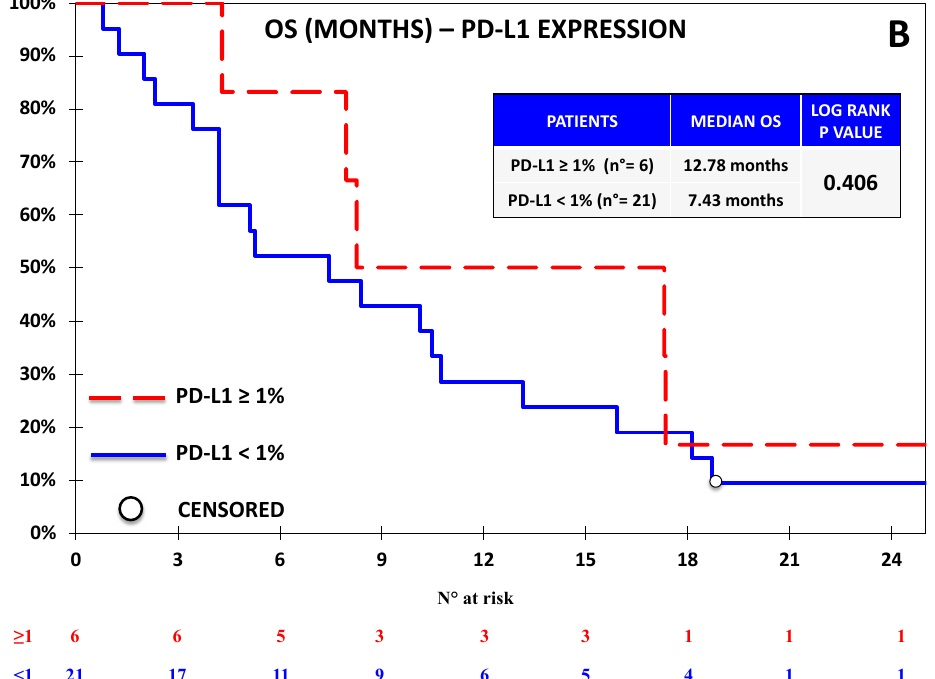
Figure 7. Kaplan–Meier curves for RECIST-PFS ( A ) and OS ( B ) based on the expression of PD-L1 defined as ≥ 1% vs. <1% in the Chemotherapy Cohort. No significant difference in terms of PFS or OS was observed on the basis of PD-L1 expression.